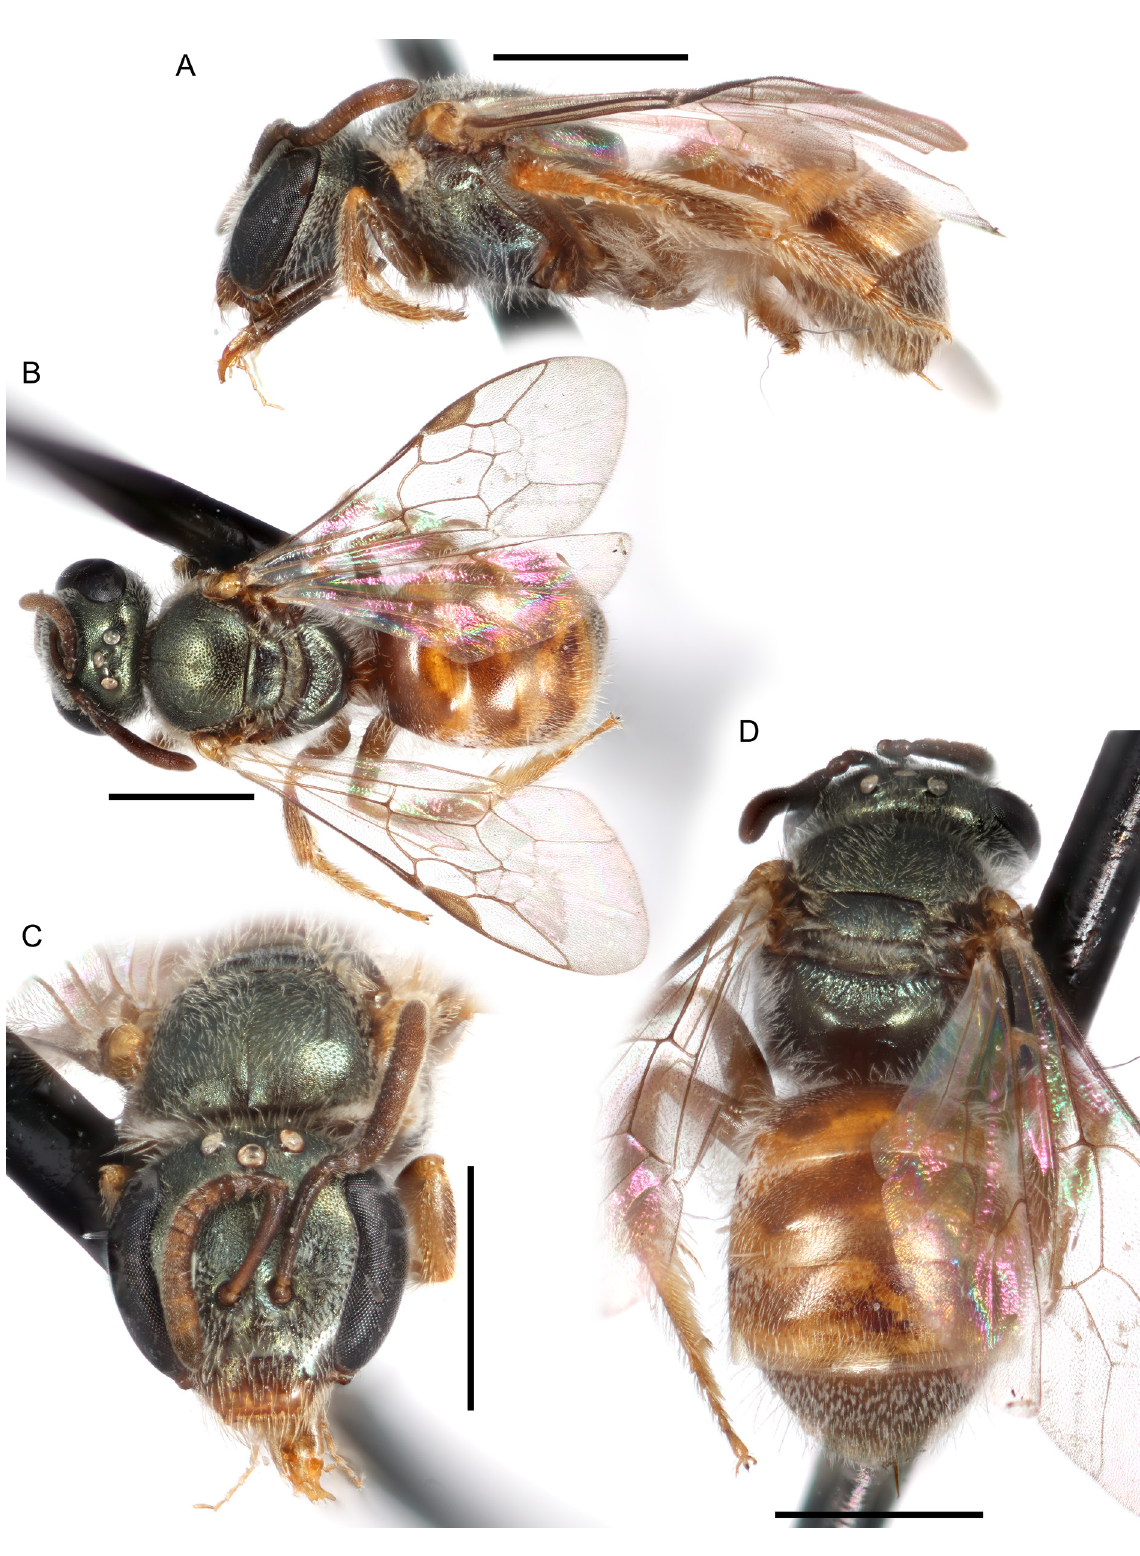
Fig. 31. Lasioglossum ( D. ) decorum sp. nov., ♀. A . Lateral habitus. B . Dorsal habitus. C . Face. D . Propodeum and metasoma. Scale bars: 1